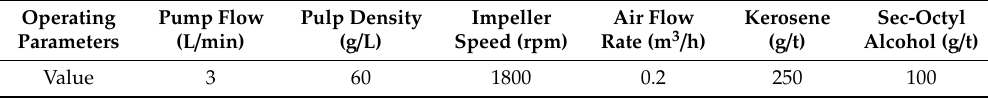
Table 3. Cavitation conditions and operating parameter values used for the flotation